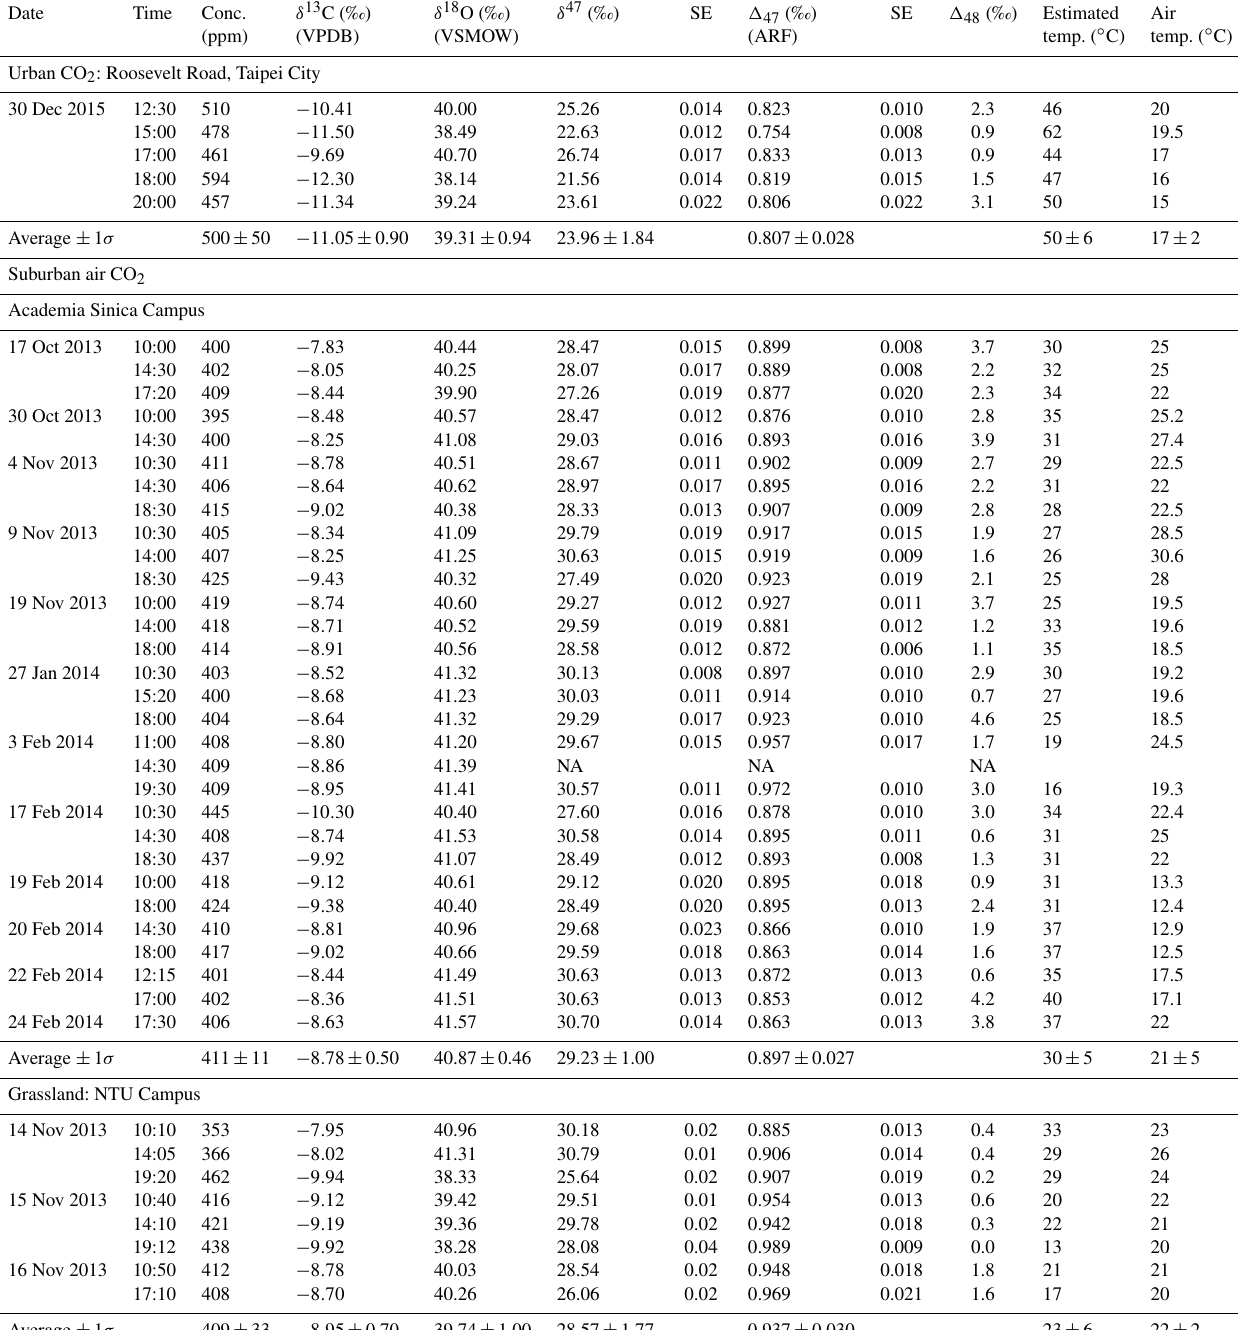
Table 4. Stable isotopic composition including clumped isotopes ( (cid:49) 47 ) for air CO 2 collected in urban and suburban stations, grassland, forest and high mountain environments. Temperatures estimated using (cid:49) 47 values and air temperatures are also